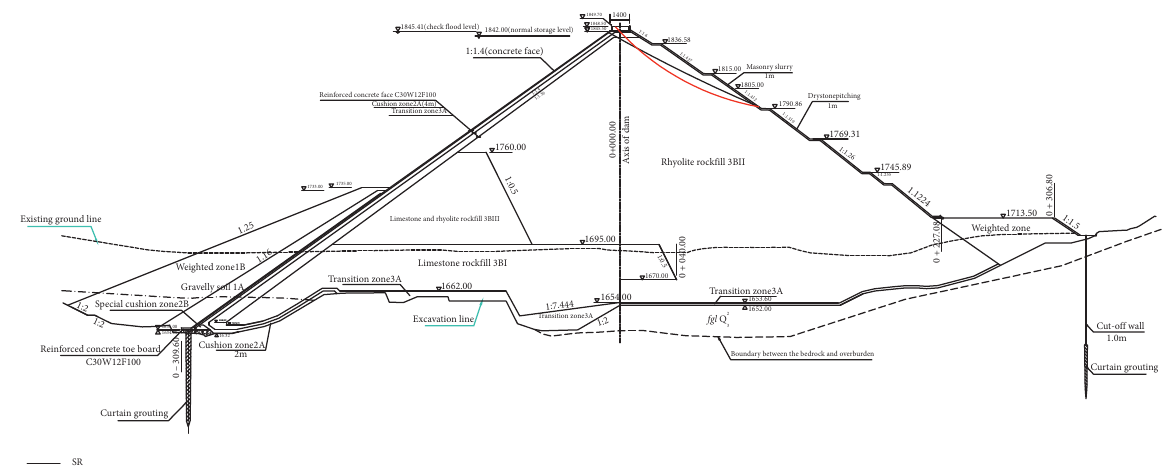
Figure 11: Most dangerous sliding surfaces in the downstream dam slopes.